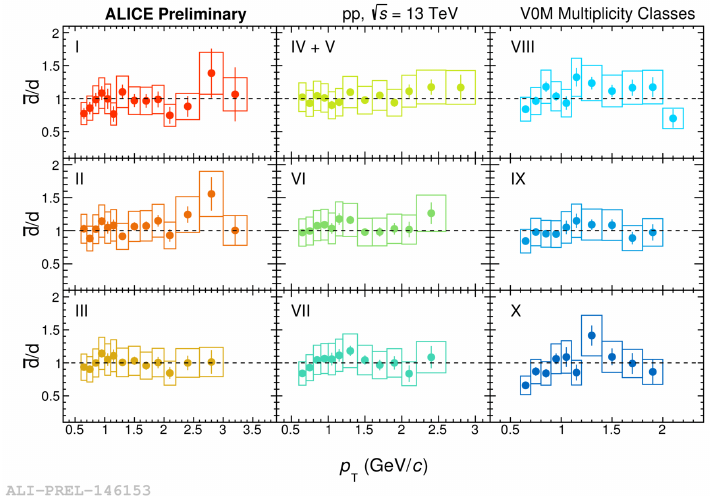
Figure 1. Ratio between the spectra of antideuterons and